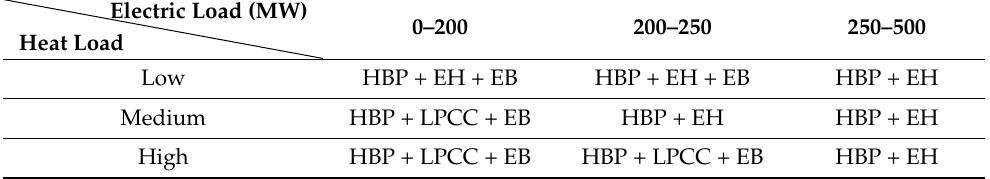
Table 3. Three optimal unit commitment modes of units under heat load of the whole plant.